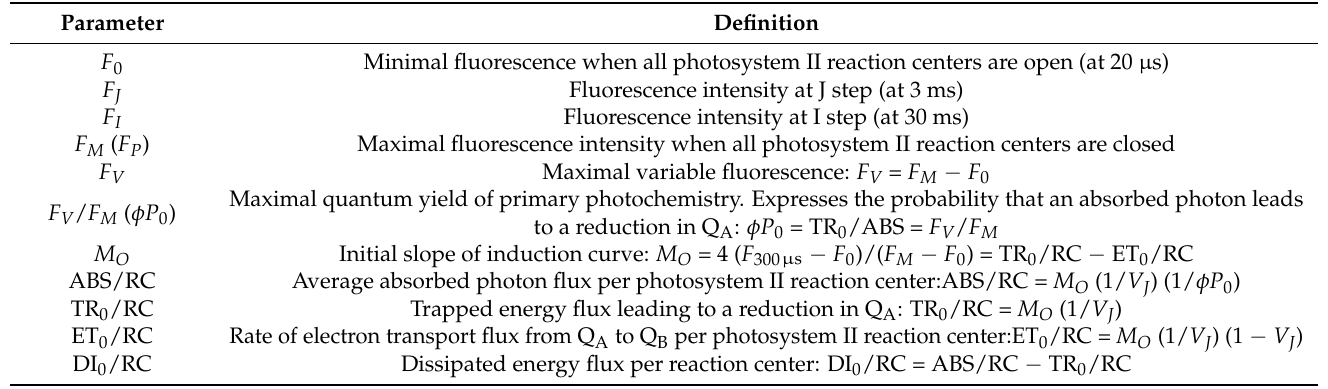
Table 1. Definitions and formulas of the chlorophyll- a fluorescence fast rise curve (OJIP) test parameters. Parameter Definition Fluorescence intensity at J step (at 3 ms) Fluorescence intensity at I step (at 30